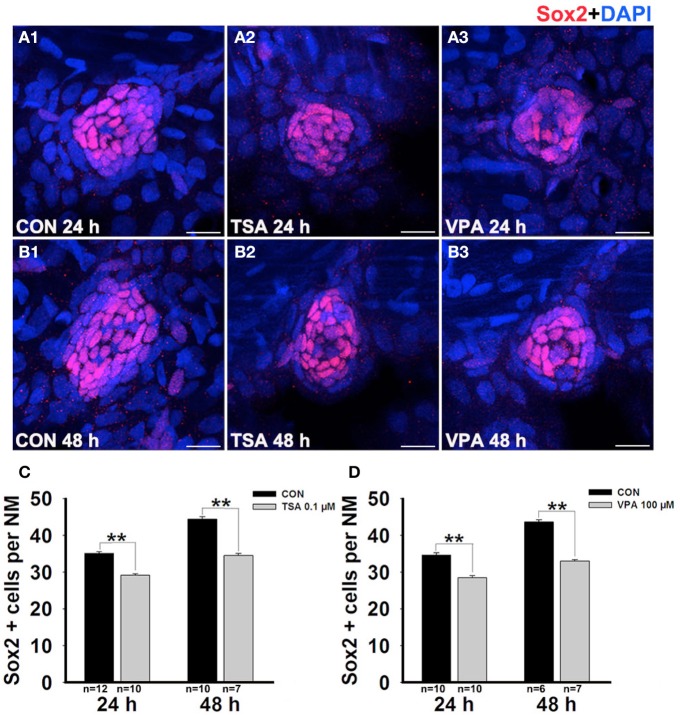
HDAC inhibitors significantly suppress SC production. (A and B) We treated larvae at 5 dpf with neomycin and monitored SC numbers over the following 2 days. Lateral line SCs are stained with Sox2 antibody. (C and D) Quantification of the number of SCs in control and TSA- or VPA-treated larvae at 24 h and 48 h after neomycin incubation. Bars are mean ± s.e.m. and n = total number of embryos. **p < 0.001.